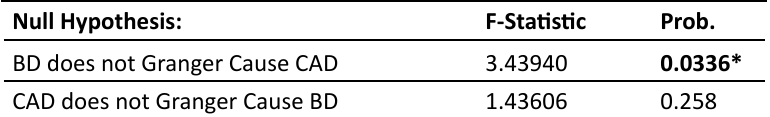
Table 1: The Result of Bivariate Granger